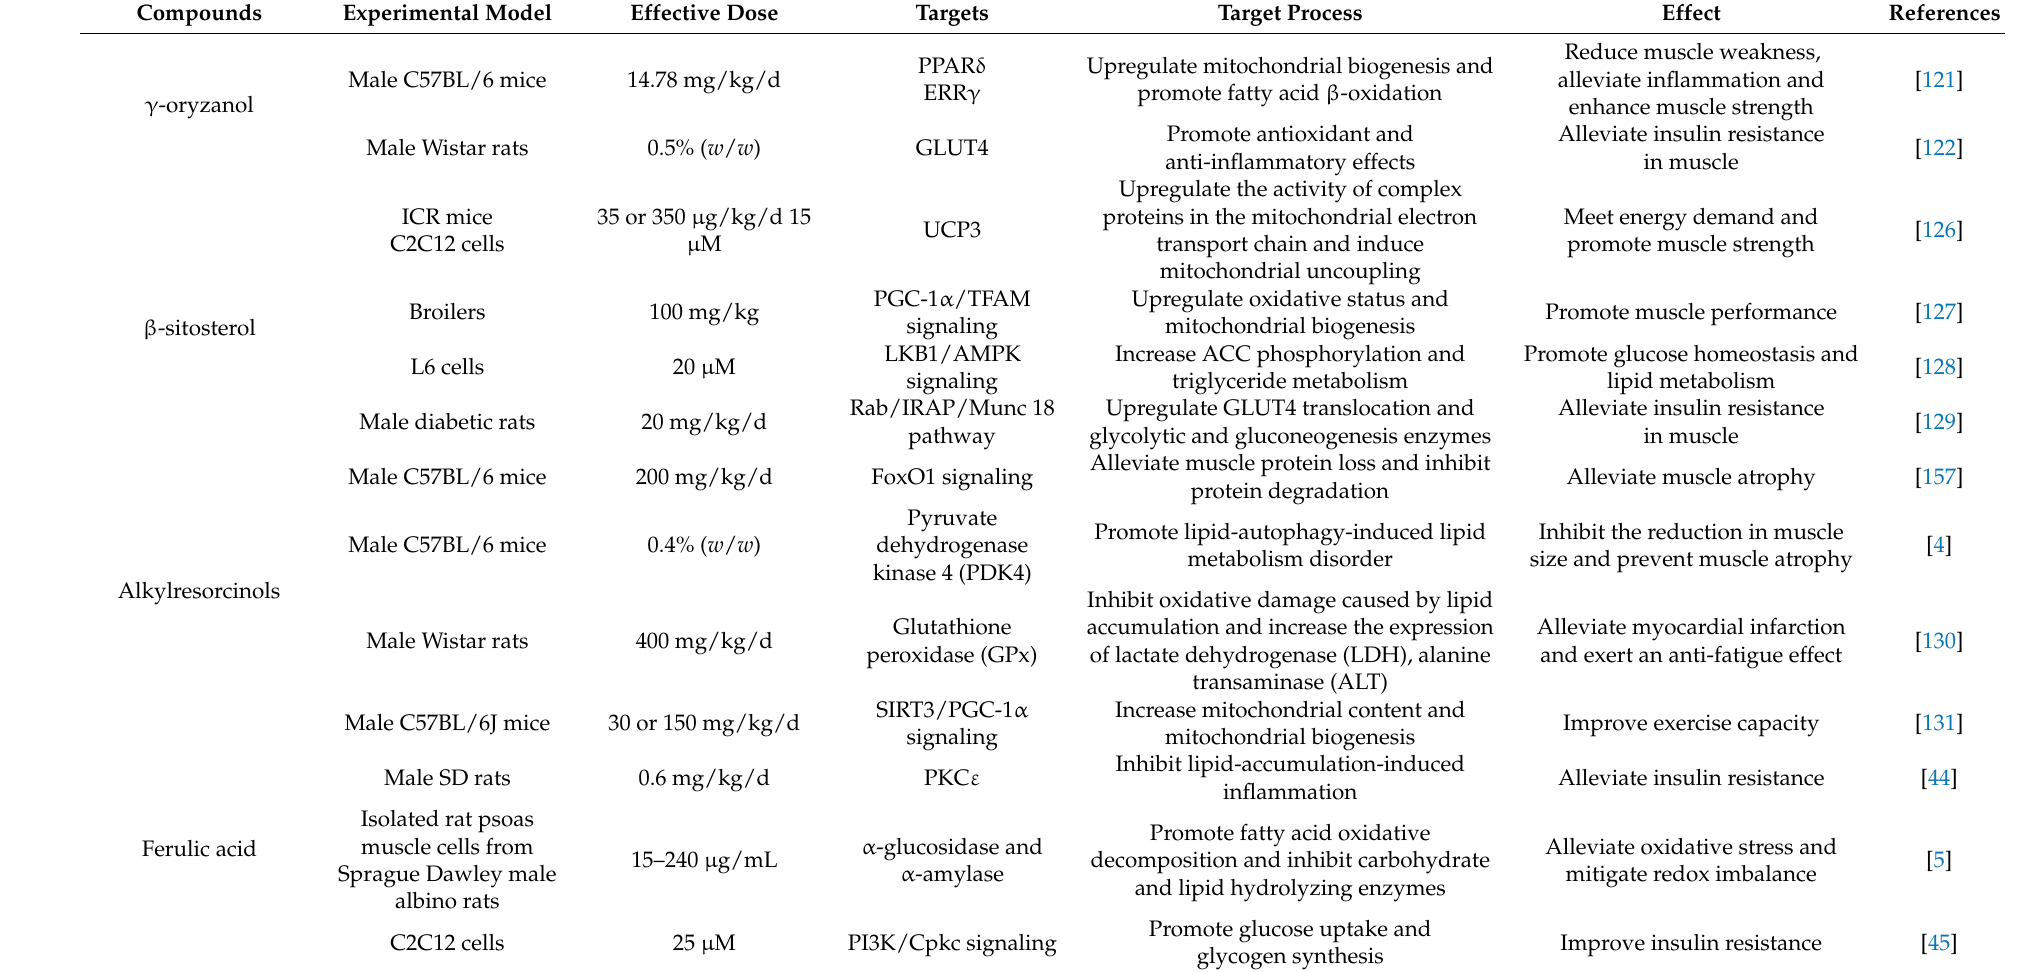
Table 2. Bioactive compounds derived from whole grains for the regulation of muscle